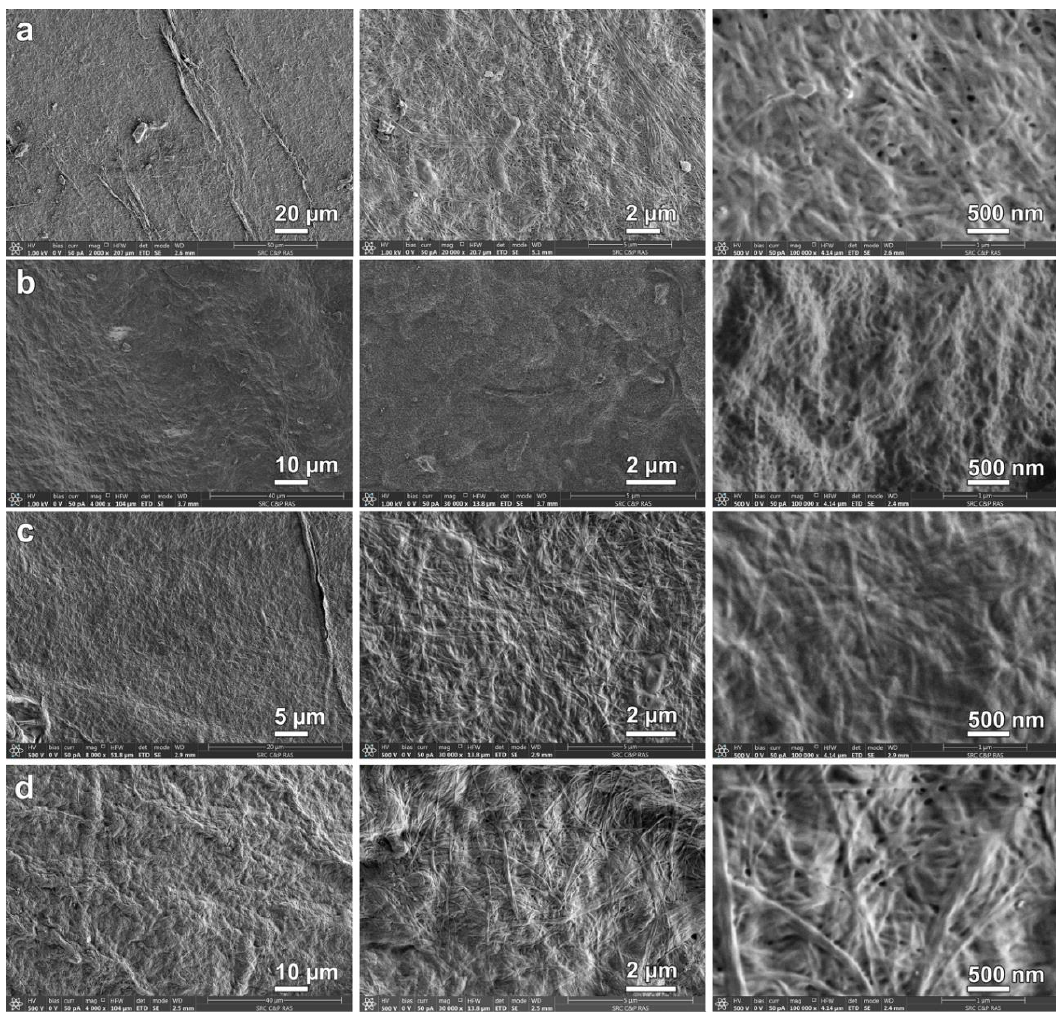
Figure 3. SEM images of surface of bacterial cellulose composites: BC ( a ); ВС–ALG–CS ( b ); ВС–HA–CS ( c ); and ВС–CAR–CS ( d ).